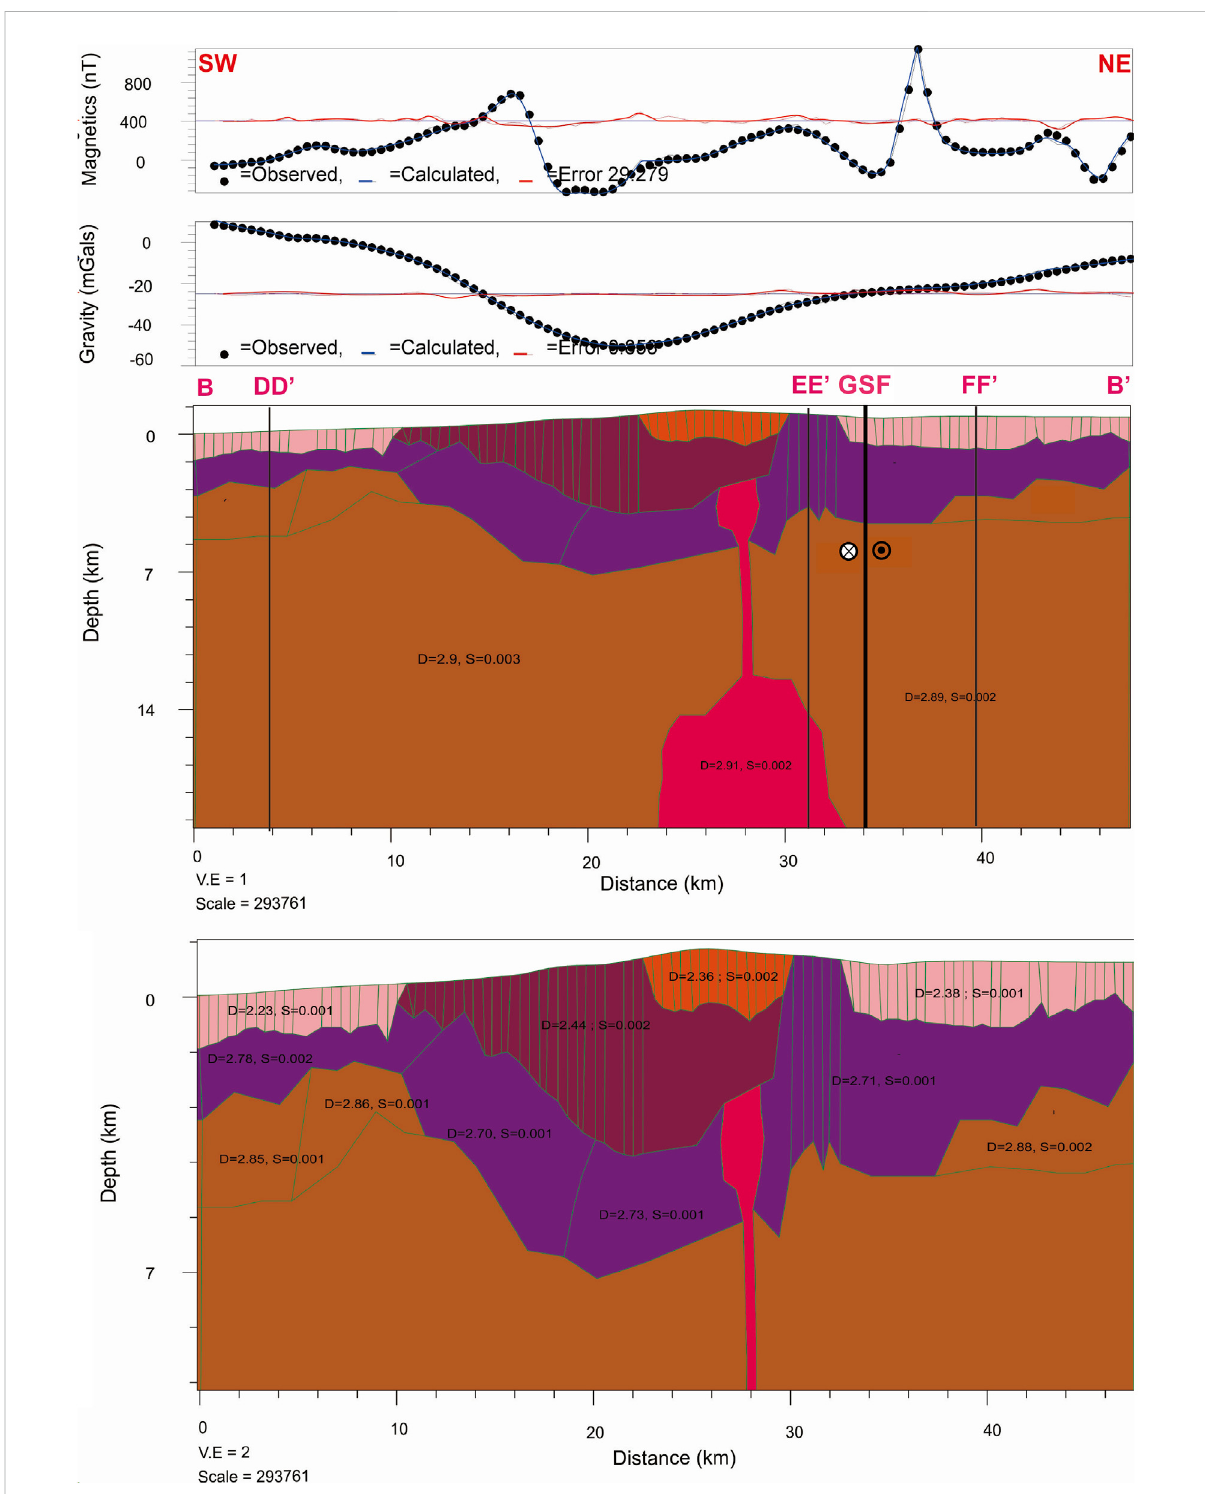
FIGURE 4 2D modeling of magnetic and gravity data of the B-B ′ pro fi le in the Sianok segment of GSF shows the subsurface structures beneath Mount Singgalang-Tandikat that include its shallow and deep magma chambers. This model also shows slivers of Permian metamorphic rocks encased in the basement rocks. This fi gure uses the same legend as that in Figure